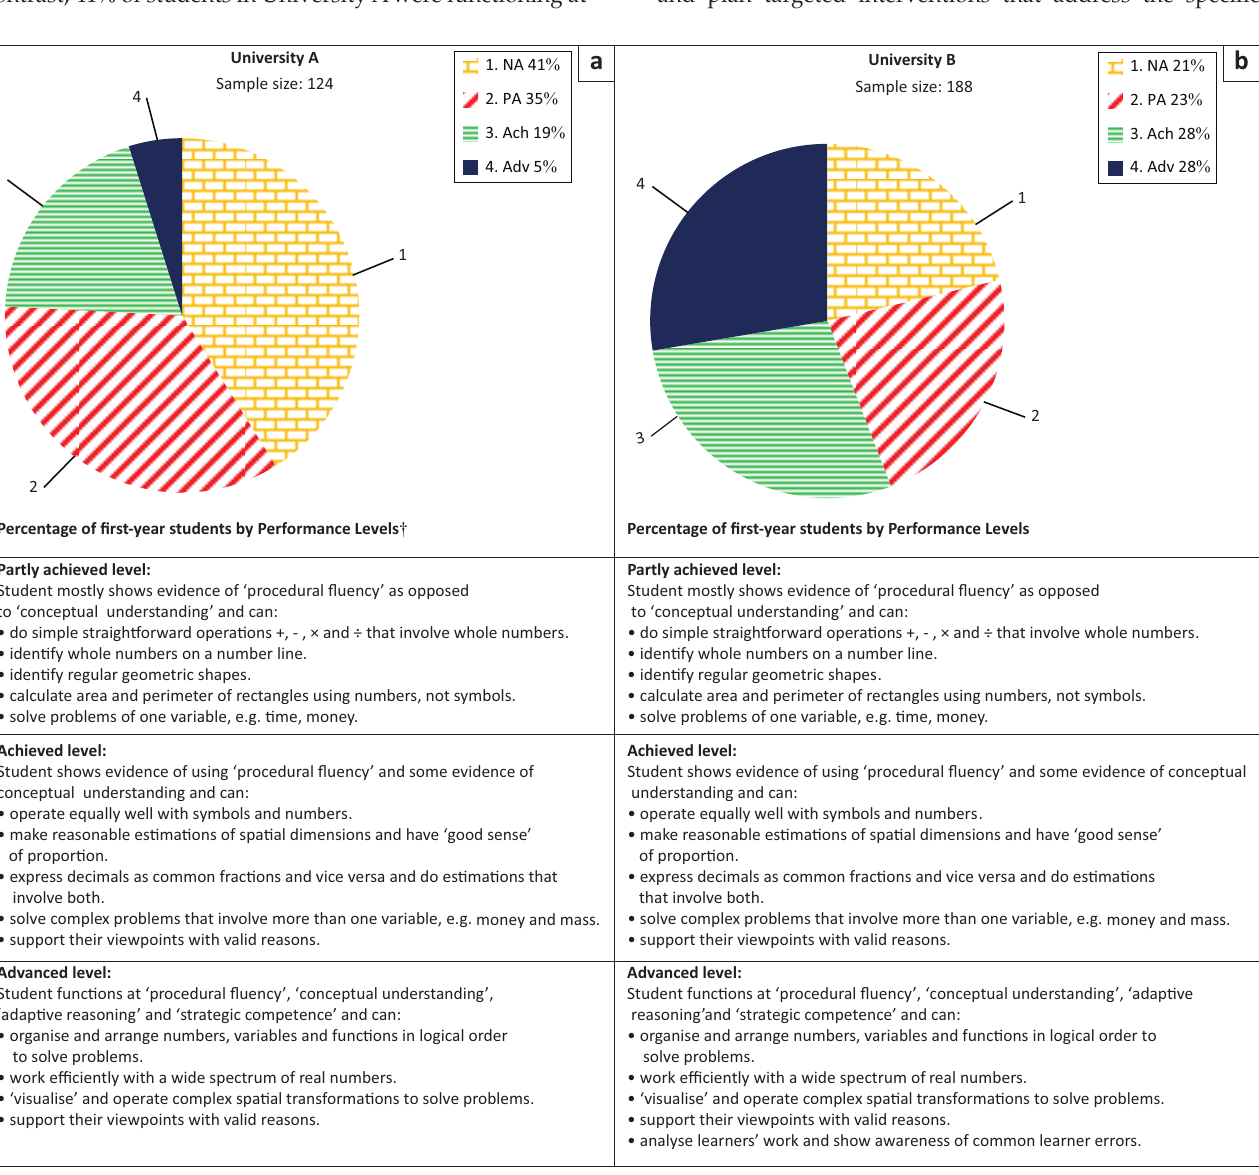
FIGURE 7: (a) First-year student 2018 performance for University A, (b) First-year student 2018 performance for University